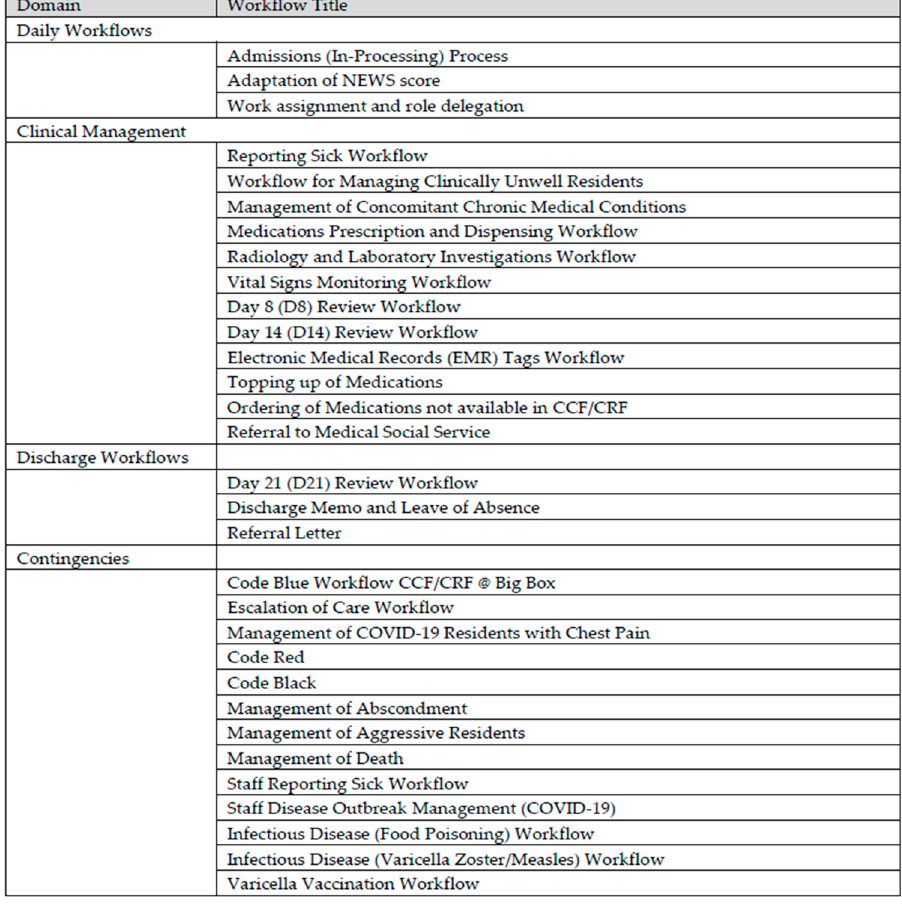
Figure 4. Workflows at the CCF/community recovery facility (CRF)@Big Box.